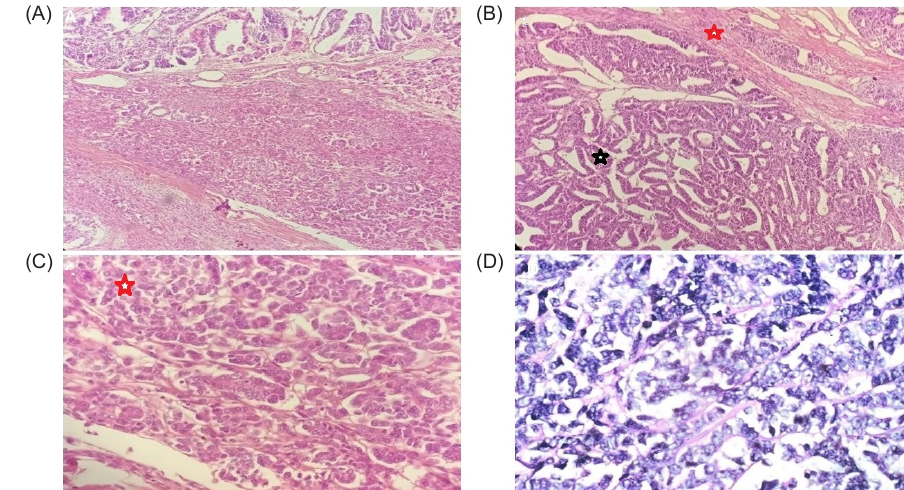
Figure 3: (A) Histopathological examination (HPE) of specimen from first patient showing features of Wilms’ tumor, 40× mag- nification. (B) HPE of specimen from second patient showing epithelial and stromal component of Wilms’ tumor. Black star highlights epithelial component and red star highlights stromal component, 100× magnification. (C) HPE of specimen from third patient showing blastemal component highlighted by red star, 200× magnification. (D) HPE of specimen from fourth patient showing only blastemal component, 400×